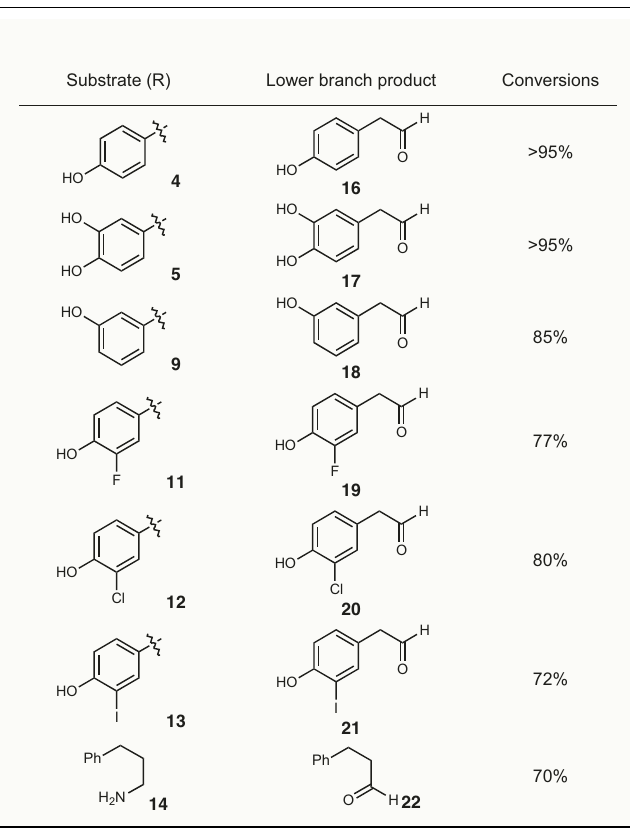
Table 1 | Lower branch conversion of amino acids and 14 into aldehydes 16 – 22